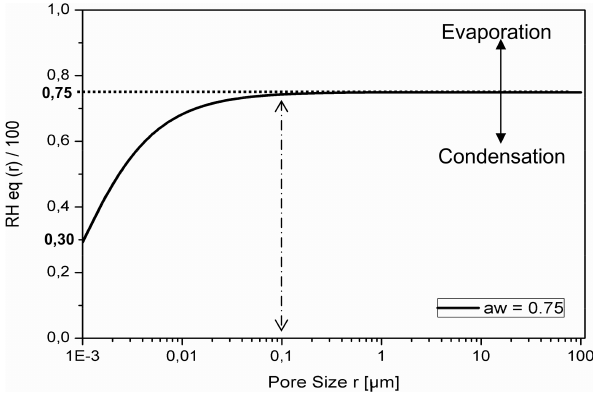
Fig. 4. Theoretical water evaporation/condensation equilibrium in halite. The model estimates the equilibrium relative humidity (RH eq ) of a NaCl-saturated solution as a function or pore radius (Benavente et al., 2003). See Supplement for more